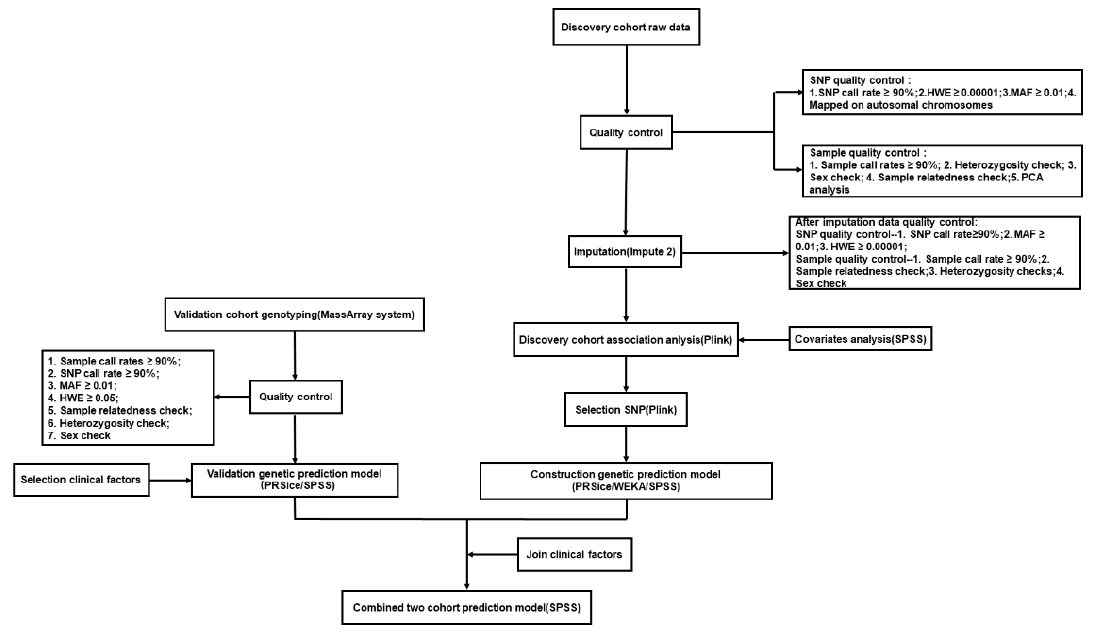
Figure 2. Methodological flow chart of the whole